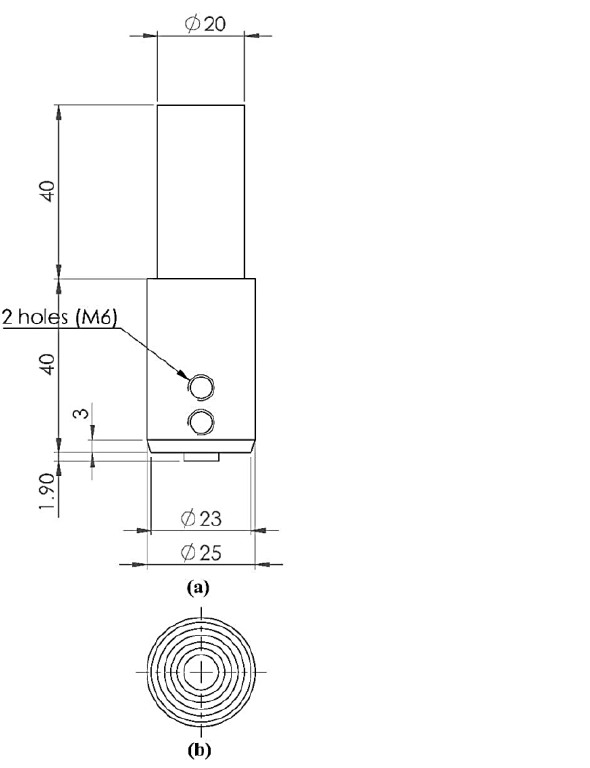
Figure 1. The friction stir diffusion cladding (FSDC) tool ( a ) side view, ( b ) bottom view of tool shoulder, showing the grooves to enhance material’s flow during cladding. (All dimensions are in mm). Table 2. The FSDC process parameters used and the corresponding sample designation (FL for 250 rpm, FM for 500 rpm, and FH for 1000 rpm. Digits 1, 2, and 3 designate 50, 100, and 150 mm/min, respectively).